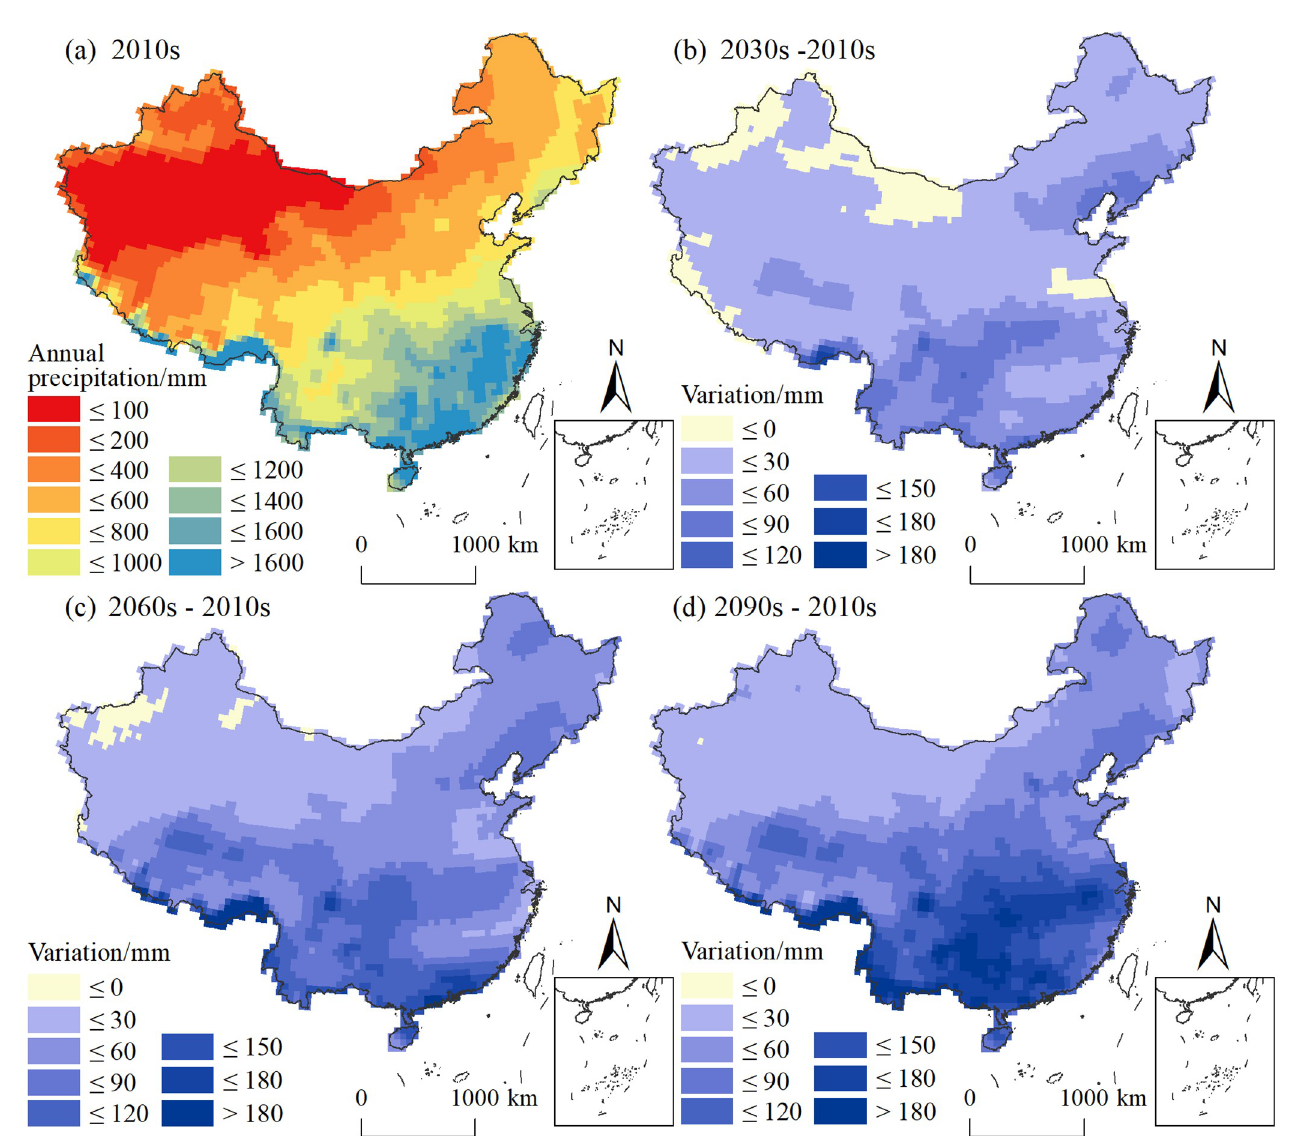
Fig 5. Temporal variations in the average annual precipitation under RCP